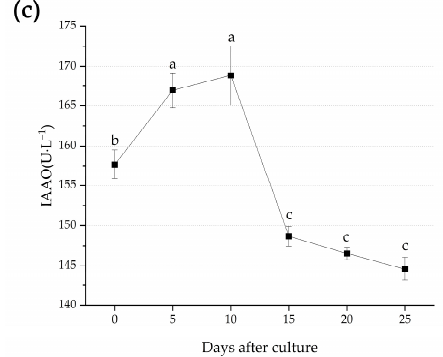
Figure 3. Changes in enzymatic activities and soluble protein contents during rooting of B. buttiana ‘Miss Manila’. ( a ) POD activities. ( b ) PPO activities. ( c ) IAAO activities. Data present the means of three replicates ± SE. Letters on the top of each point show p < 0.05; the same letters show a non-significant difference, while different letters show a significant difference between different days after culture.